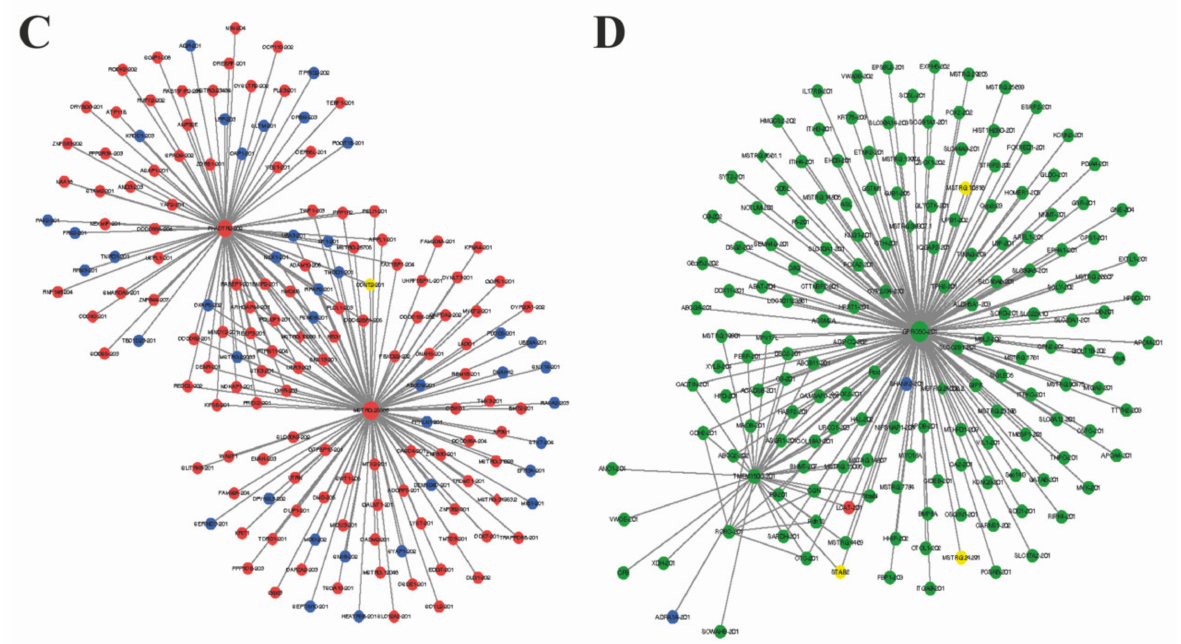
Figure 5. The weighted gene co-expression network analysis. ( A ) The hierarchical clustering dendrogram of lncRNA- mRNA co-expression modules in subcutaneous adipose tissue. Each branch represents a cluster of lncRNAs or mRNAs. Dynamic tree cut indicate original split module, and merged dynamic indicate final merged modules. ( B ) The hierarchical clustering dendrogram of module eigengenes and heatmap of adjacencies using WGCNA; red indicate positive correlation; blue indicate negative correlation. The co-expression network diagram of mRNAs and LncRNAs in the ( C ) darkred module and ( D ) darkturquoise module. Rhombic and circular nodes represent lncRNA and mRNA, respectively. Color indicates differential expression level: blue: no changes; red: up-regulation; green: down-regulation; yellow: up- and